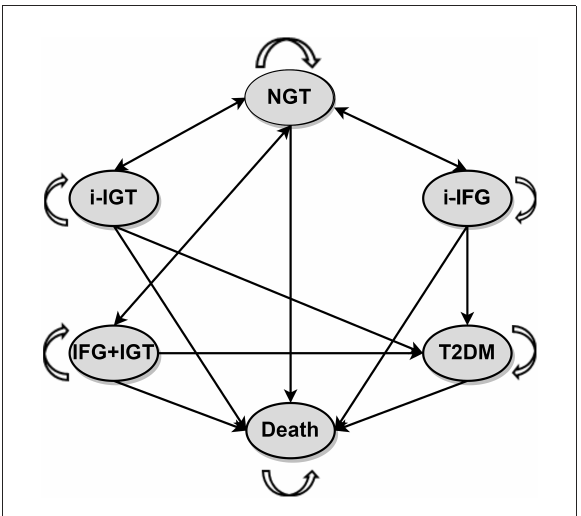
FIGURE2 Markov state-transition model with the six health states. T2DM, type 2 diabetes mellitus; I-IFG, isolated impaired fasting glucose; I-IGT, isolated impaired glucose tolerance; IFG + IGT, impaired fasting glucose and impaired glucose tolerance; NGT, normal glucose